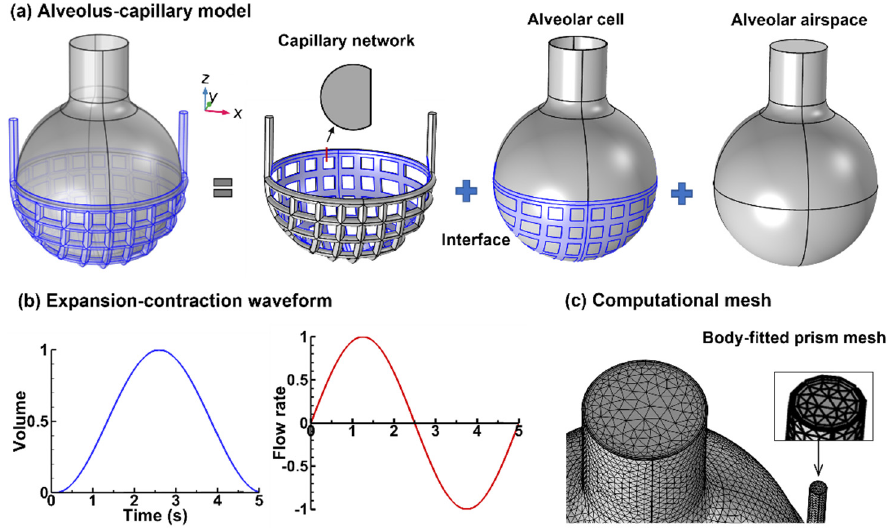
Figure 1. Computational model: ( a ) alveolus–capillary model geometry consisting of a capillary vessel network, alveolar cells (membrane), and alveolar airspace, ( b ) model expansion–contraction waveforms, with the oscillation amplitude depending on the tidal volume, and ( c ) computational mesh with fine prism mesh in the near-wall region.